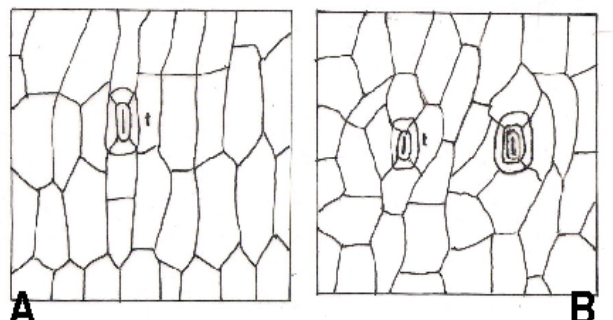
Fig. 1. Surface view of leaf epidermis, abaxial (A) and adaxial (B) of Agave americana propagated with 1.25 cc daily watering regime showing tetracytic (t) stomata x1200